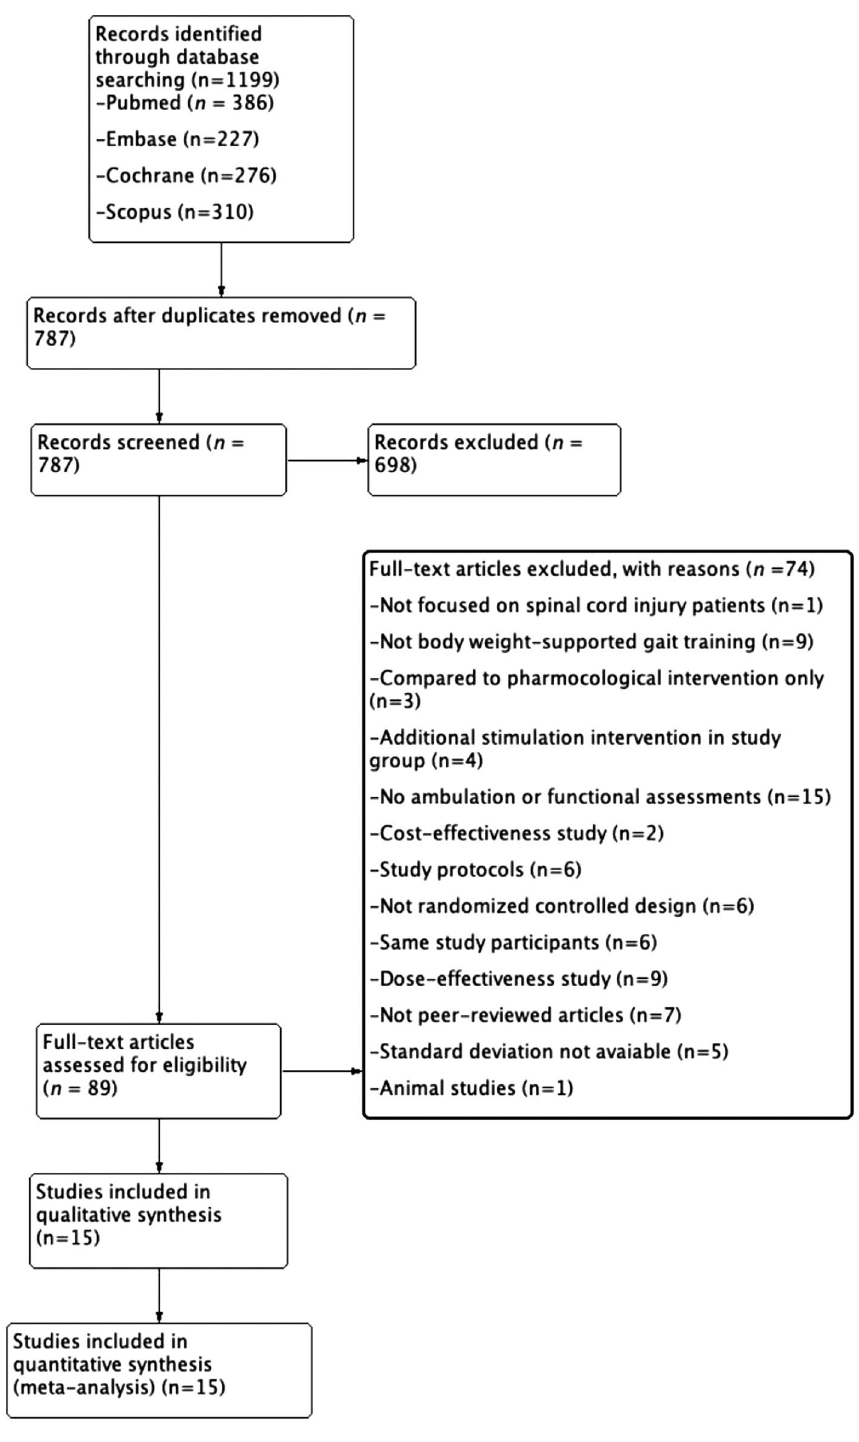
Figure 1. Flowchart of study